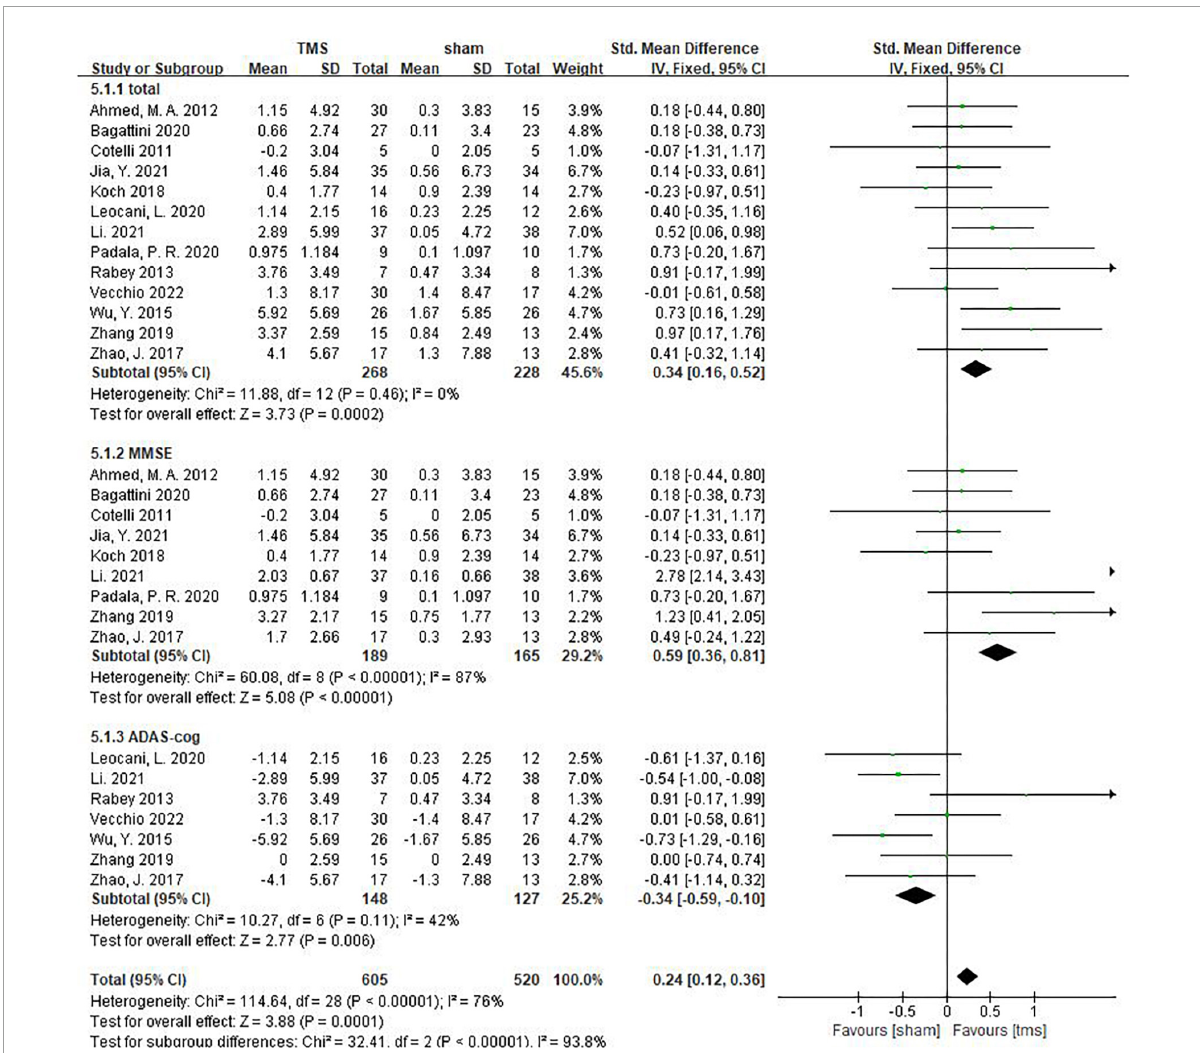
FIGURE3 The effect of repetitive transcranial magnetic stimulation (rTMS) on global cognitive functions.